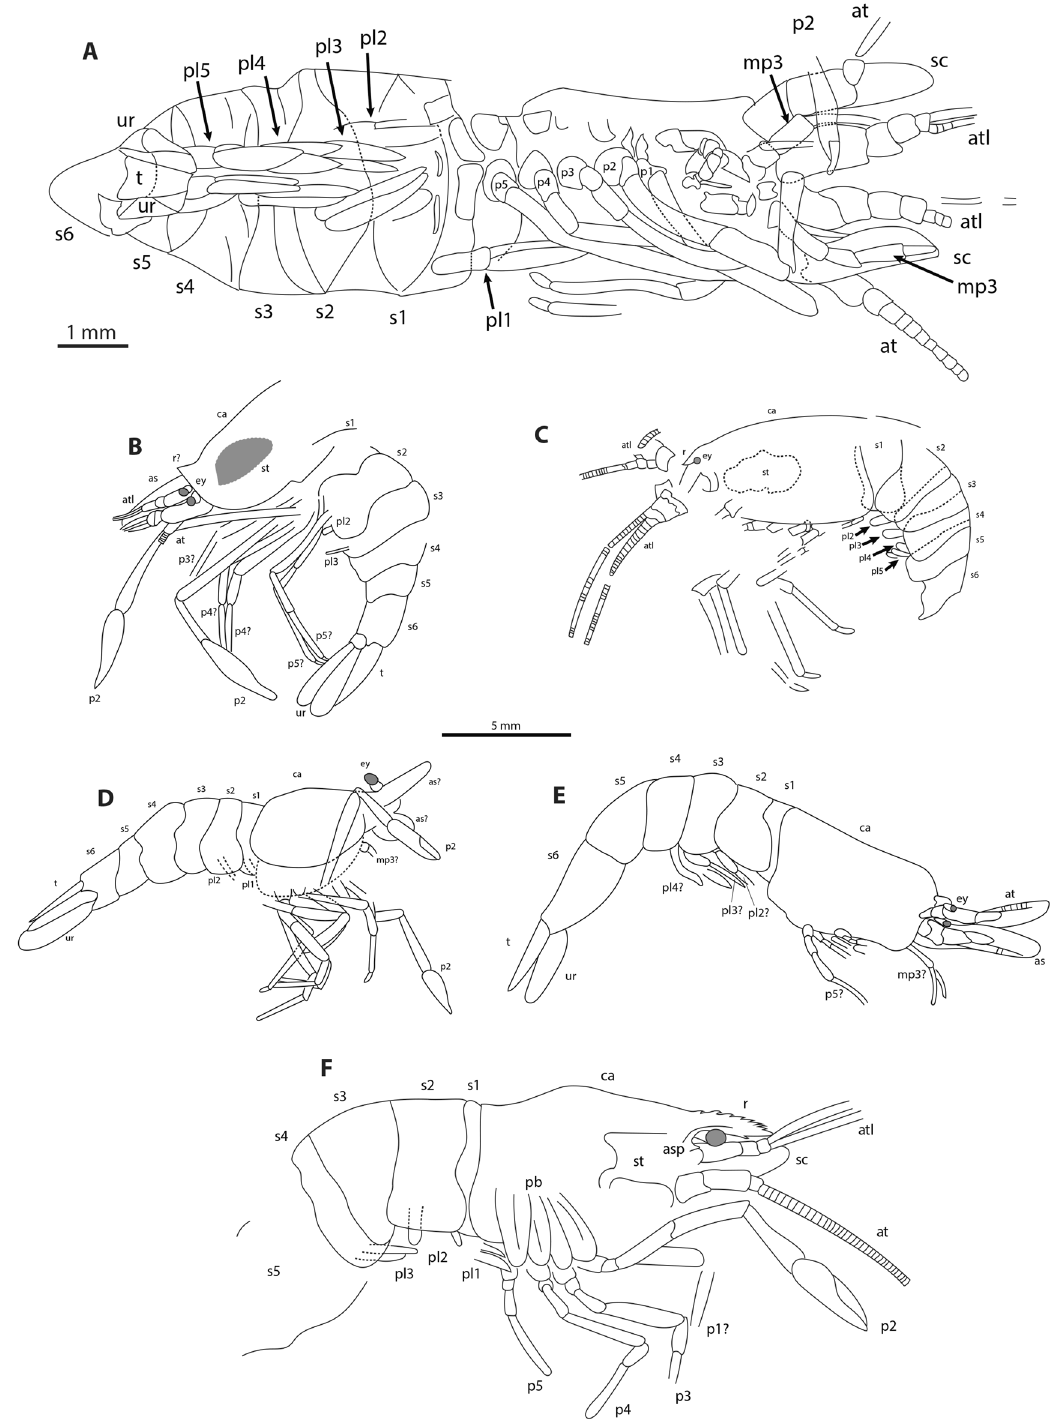
Figure 4. Interpretative drawings of the paratypes of Bechleja brevirostris n. sp. based on both sides of the fossils. ( A ) HLMD-Me 10684; ( B ) SF-MeI 13611; ( C ) HLMD-Me 13920; ( D ) SF-MeI 14640; ( E ) SF-MeI 16018; ( F ) HLMD-Me 13919. Abbreviations of morphological characters same as the Fig. 3 with the addition of as, antennal scale/scaphocerite; asp, antennal spine; mp3, third maxilliped; pb, pleurobranchiae; pl1, first pleopod; pl2, second pleopod; pl3, third pleopod; pl4, fourth pleopod; t, telson; ur, uropod. B-F at the same